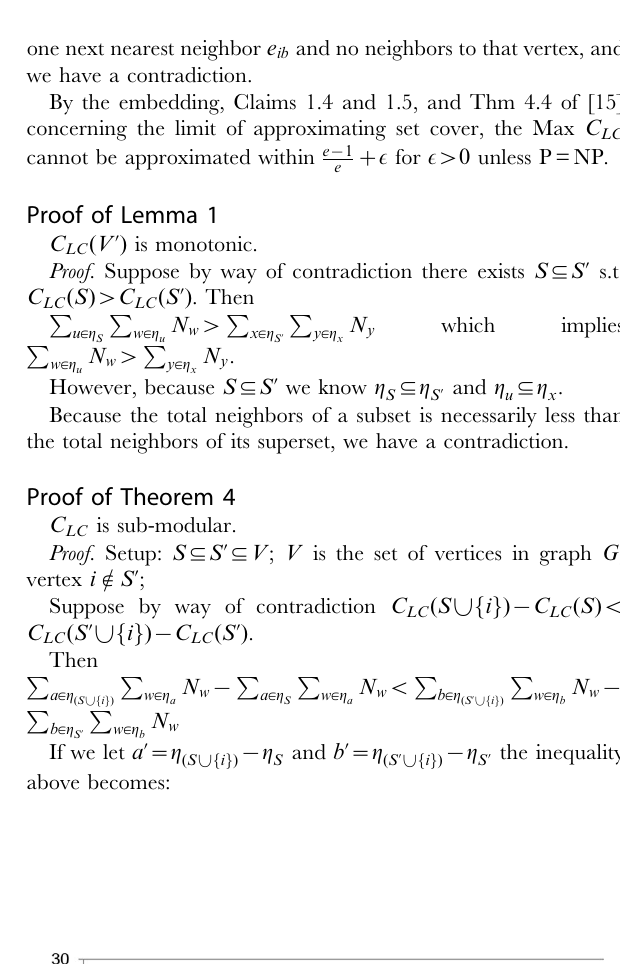
Nodes Edges CLC Size CLC Time Betweenness Closeness